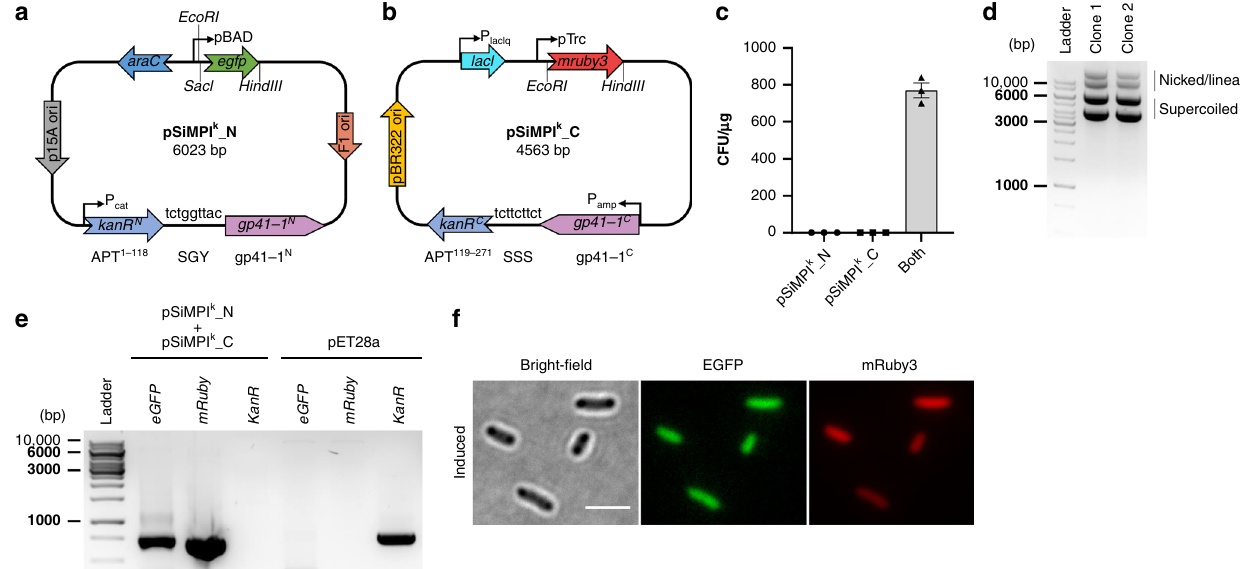
Fig. 2 The SiMPl method based on kanamycin. a , b Schematic showing the main features found on the SiMPl plasmids. pSiMPl k _N ( a ) and pSiMPl k _C ( b ) are derivatives of pBAD33 and pTrc99a, respectively. The chloramphenicol resistance gene in pBAD33 is replaced by a fragment of the kanamycin resistance gene encoding amino acids 1 to 118 of aminoglycoside 3 ′ -phosphotransferase followed by the N-terminal fragment of the split gp41-1 intein. Similarly, the ampicillin resistance gene in pTrc99a is replaced by the C-terminal fragment of gp41-1 followed by a fragment of the kanamycin resistance gene encoding amino acids 119 to 271 of aminoglycoside 3 ′ -phosphotransferase. For more ef fi cient splicing, the local exteins (SGY and SSS) are included. c Bar graph showing the transformation ef fi ciency in E. coli TOP10 cells of the indicated plasmids. Values represent mean (± standard error of the mean) of three independent experiments. d Ethidium bromide-stained agarose gel showing plasmid DNA isolated from two randomly picked clones obtained after transformation of E. coli TOP10 cells with the SiMPl plasmids shown in ( a ) and ( b ). e PCR analysis of the SiMPl plasmids isolated from bacteria. pET28a was used as control to show the product obtained after ampli fi cation of the full-length kanamycin resistance gene. f Representative fl uorescence microscopy images of E. coli TOP10 cells carrying the SiMPl plasmids shown in ( a ) and ( b ) induced with 0.1% arabinose and 1 mM IPTG for 3 h. Scale bar, 3 μ m. Source data are provided as a Source Data fi